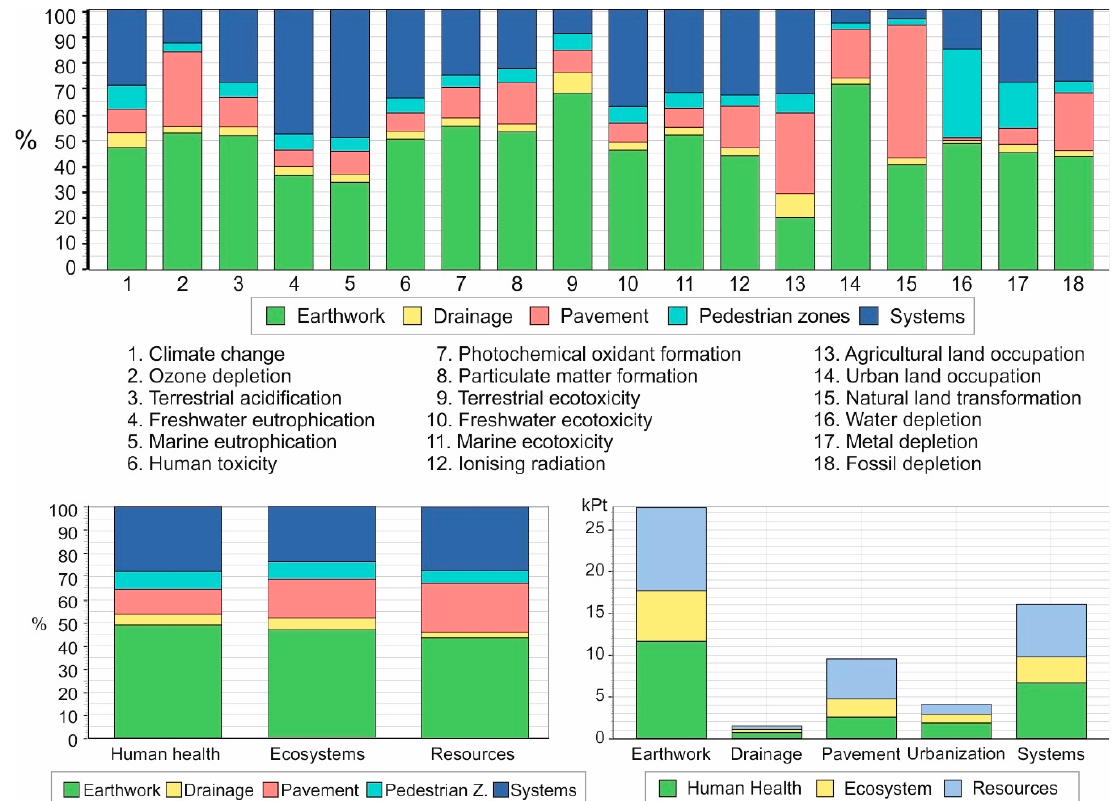
Figure 5. Life cycle environmental impacts of the road.